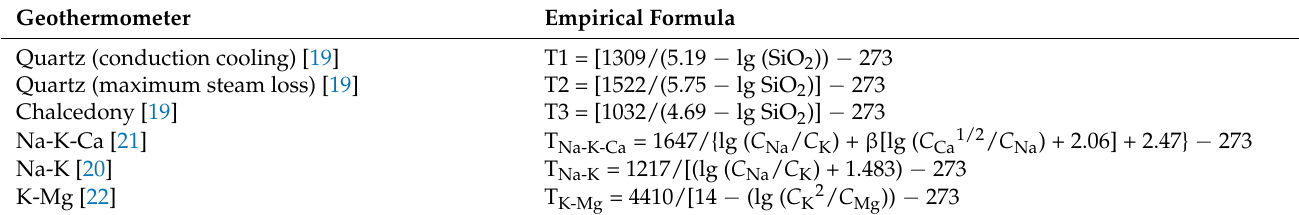
Table 2. Geothermometry equations (in ◦ C) for the cation and silica geothermometers used in this paper. C: concentration (mg/L); T1–T3 are the geothermometers estimated with dissolved SiO 2